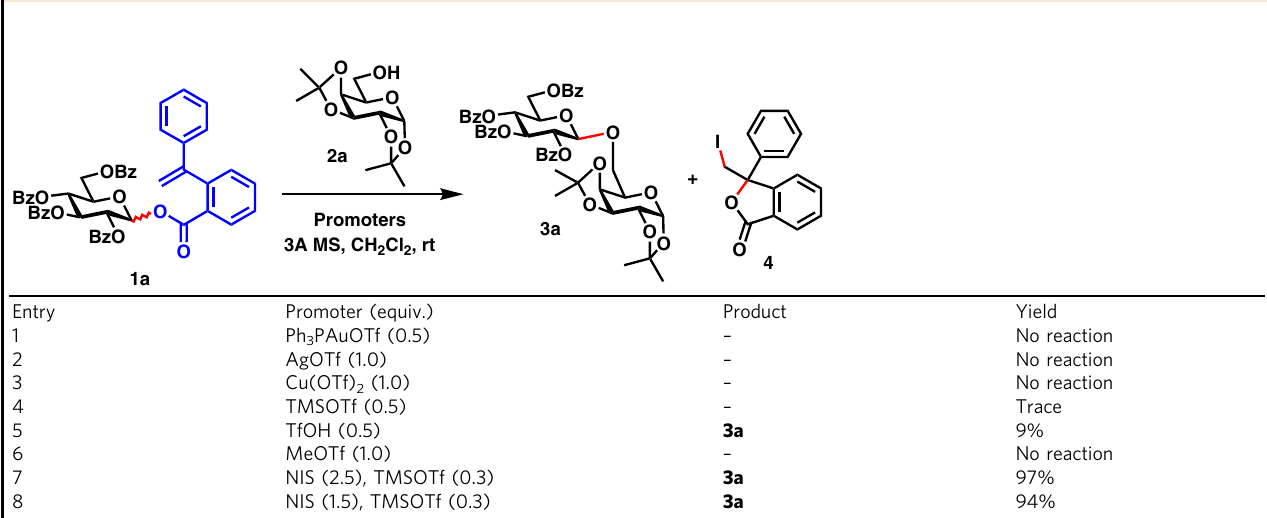
Table 1 Conditions optimization for glycosylation with perbenzoyl glucosyl PVB 1a.